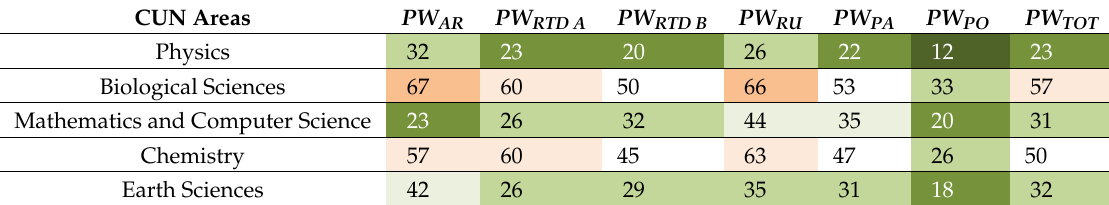
Table 11. Proportion (%) of women by academic role in physics, biological sciences, mathematics and computer science, chemistry, and earth sciences (author’s elaboration on MIUR data, 2017).